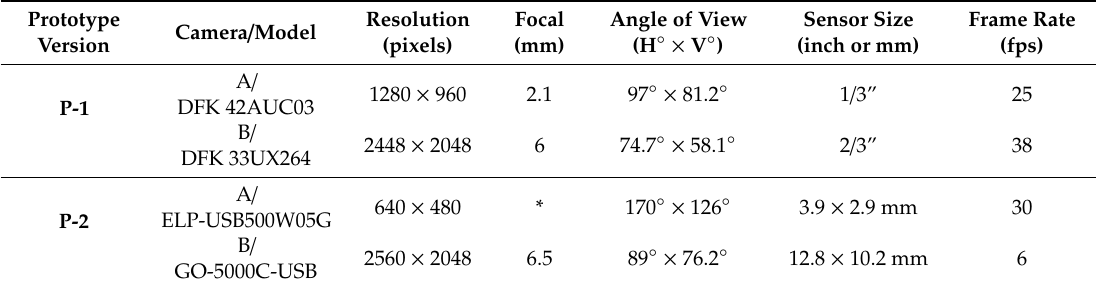
Table 1. Main technical characteristics of cameras and associated lenses used in the two